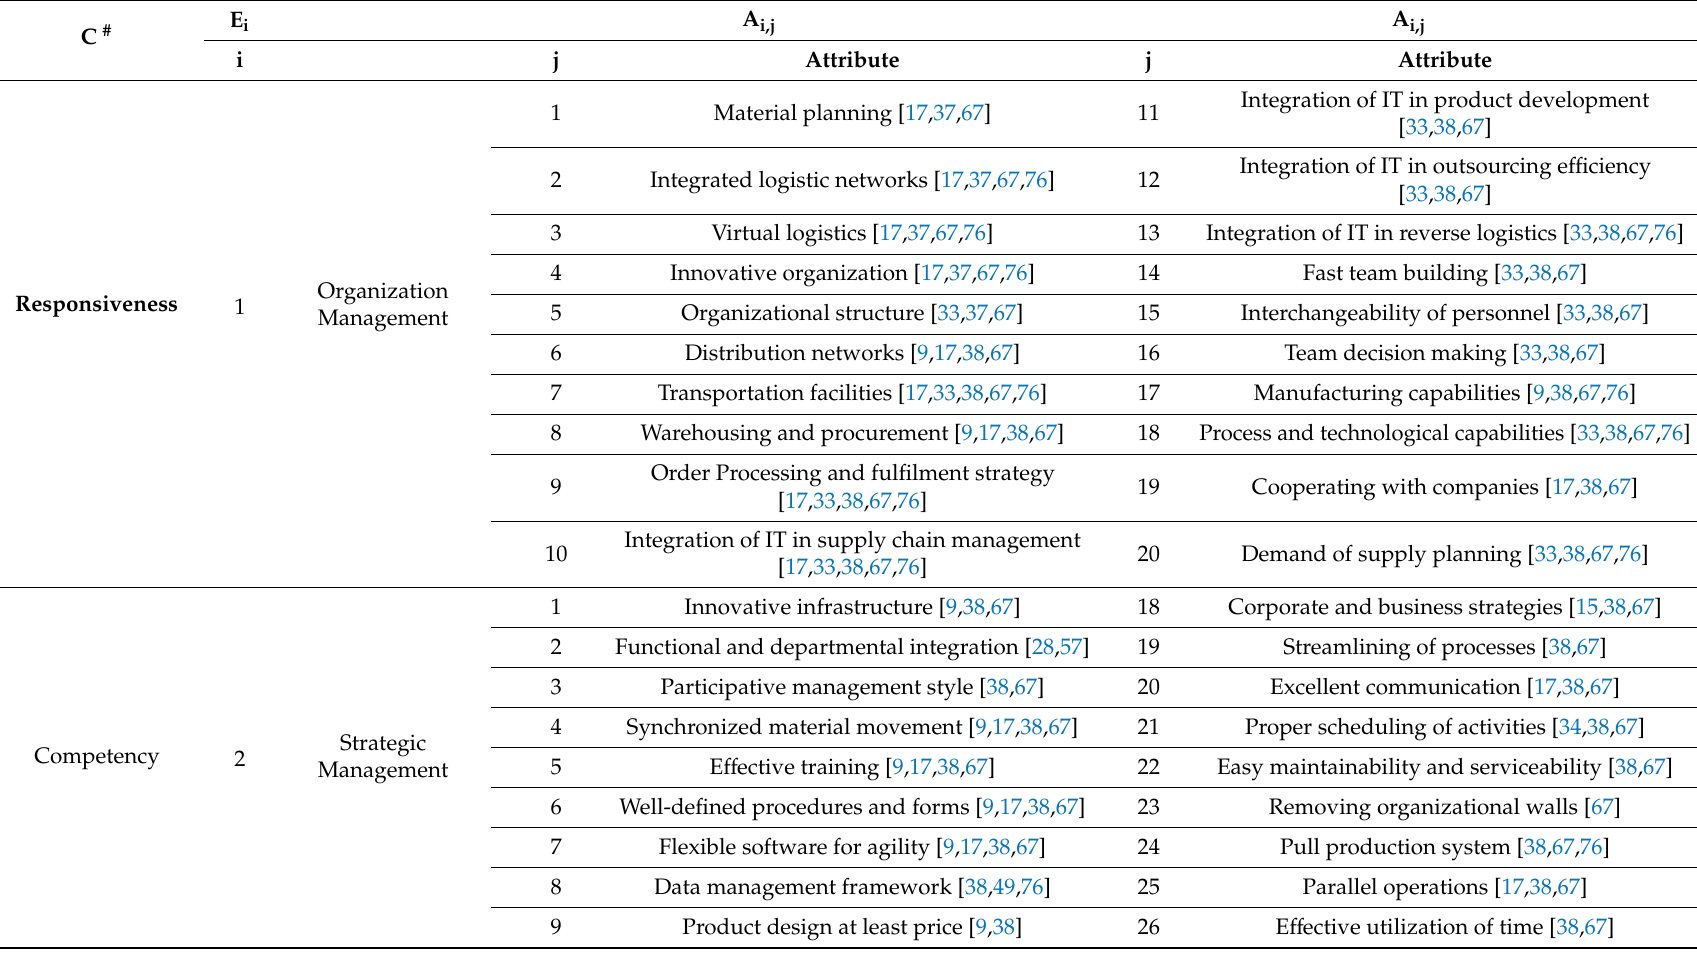
Table 2. Capabilities, enablers, and attributes for evaluating agility in supply